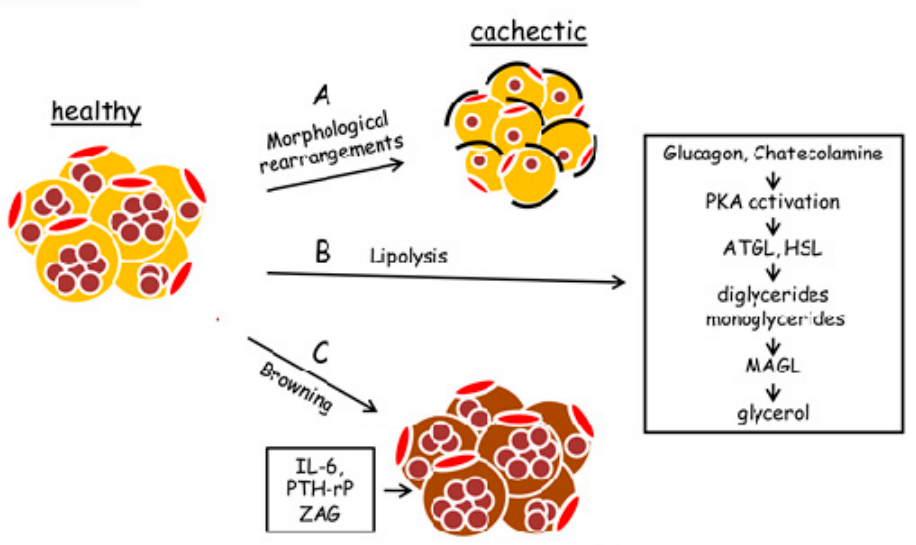
Figure 2. Modifications, occurring in adipose tissue in cancer cachexia. Cancer cachexia provokes both phenotypic and metabolic modifications in adipose tissue. ( A ) Healthy adipocytes undergo morphological rearrangements, ranging from a decrease of cell volume to fibrosis formation. ( B ) Cachectic adipocytes are characterized by enhanced lipolysis, leading to a considerable intracellular triglyceride breakdown. Lipolysis is activated by hormonal signals (as glucagon and catecholamine) that activate protein kinase A (PKA). PKA enhances adipocyte triglyceride lipase (ATGL) and hormone-sensitive lipase (HSL) activity. These enzymes induce the cleavage of two fatty acids from glycerol, forming diglycerides and monoglycerides. Monoacylglycerol lipase